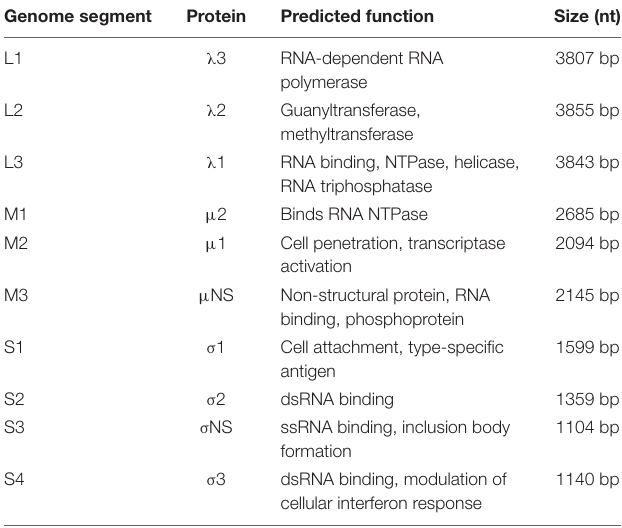
TABLE 3 | The phocid orthoreovirus 1 (PhRV1) genome characterization by